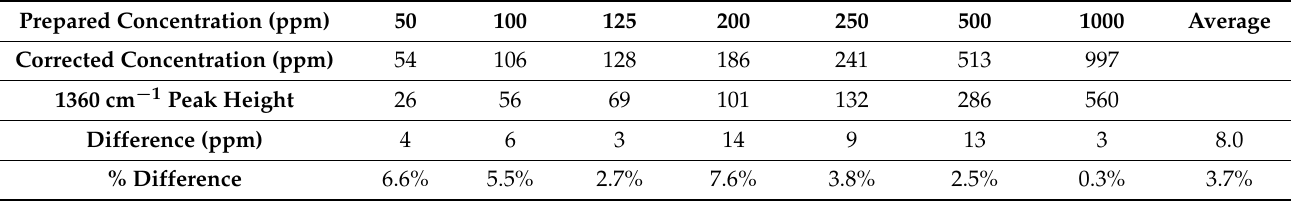
Table 2. Series 2 prepared HCO 3 − concentrations in water containing 2650 ppm sulfate, corrected concentrations based on the linear fit to the data, measured 1360 cm − 1 peak heights, ppm and percent differences between prepared and corrected calculations, and average